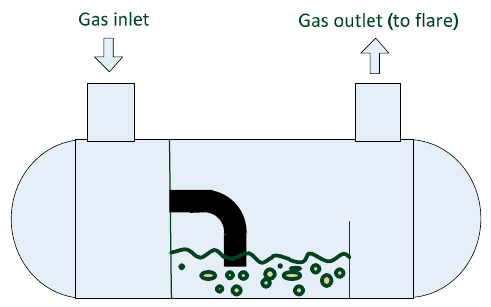
Figure 3. A typical water closure in horizontal arrangement.